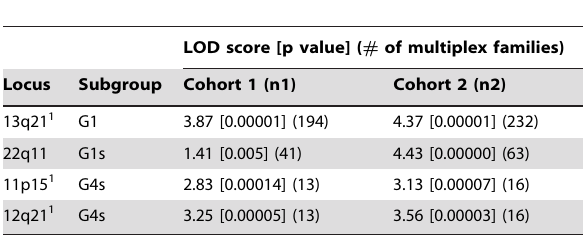
Table 1. Improvement of maximum LOD scores in subgroups with addition of new